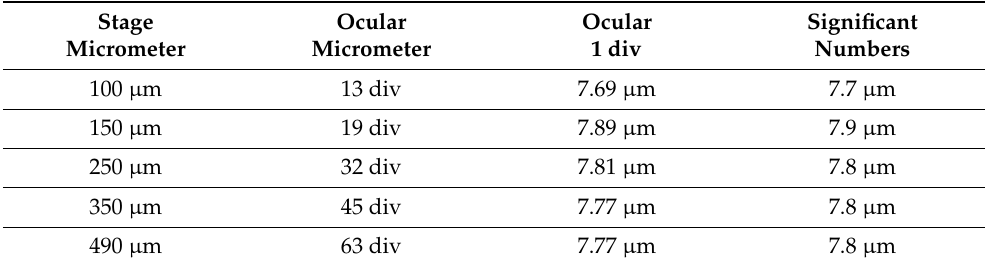
Table 1. Example of the calibration of an ocular micrometer (graticule) using a 10x/0.22 NA micro- scope objective and a stage micrometer from Muhwa